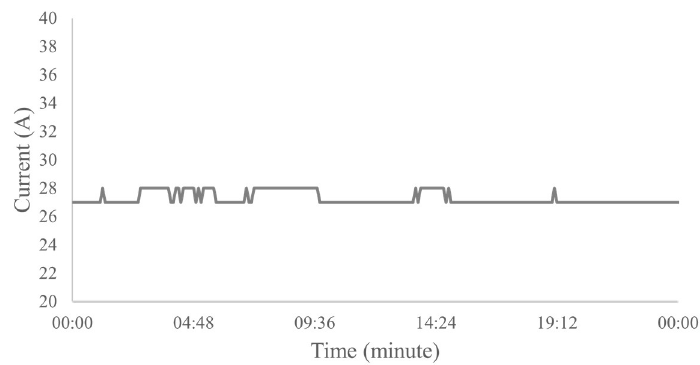
Figure 5. Example of a real well operating normally for 24 h.